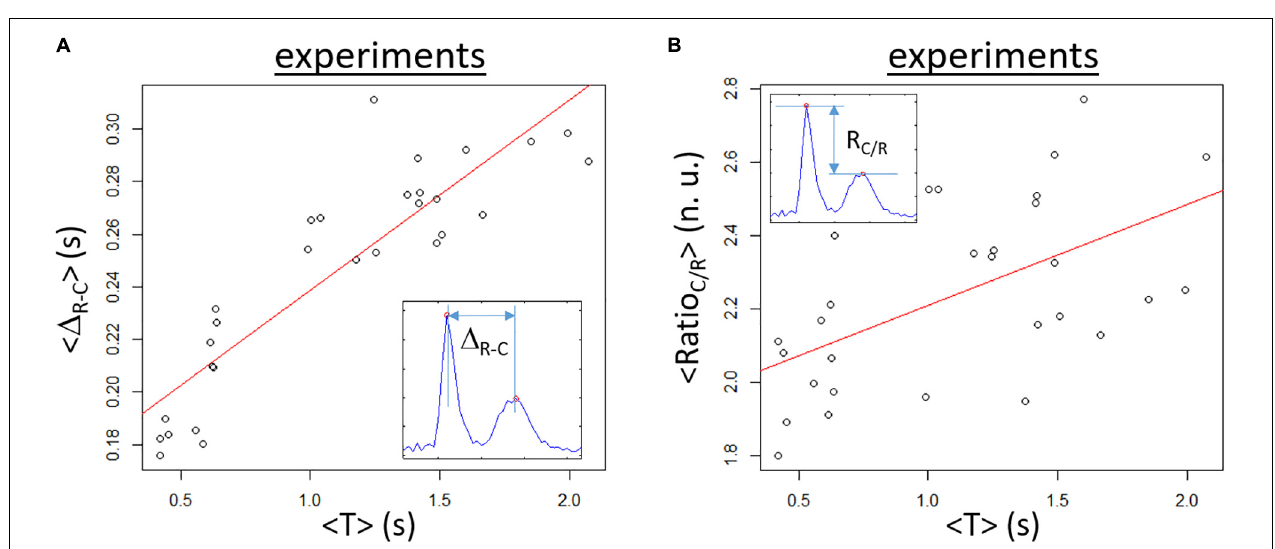
FIGURE 7 | Experimental data obtained for samples in spontaneous rhythm. (A) Mean temporal (cid:49) R - C ( <(cid:49) R - C > ) is increasing when the mean T ( < T > ) is augmenting. The red line corresponds to the linear regression fit (slope of 0.072, p < 0.001, corr. = 0.89). (B) Mean Ratio C / R ( < Ratio C / R > ) as a function of < T > showing a slight augmentation with increasing < T > . The linear regression line (red line) has a slope of 0.276 ( p < 0.01, corr =